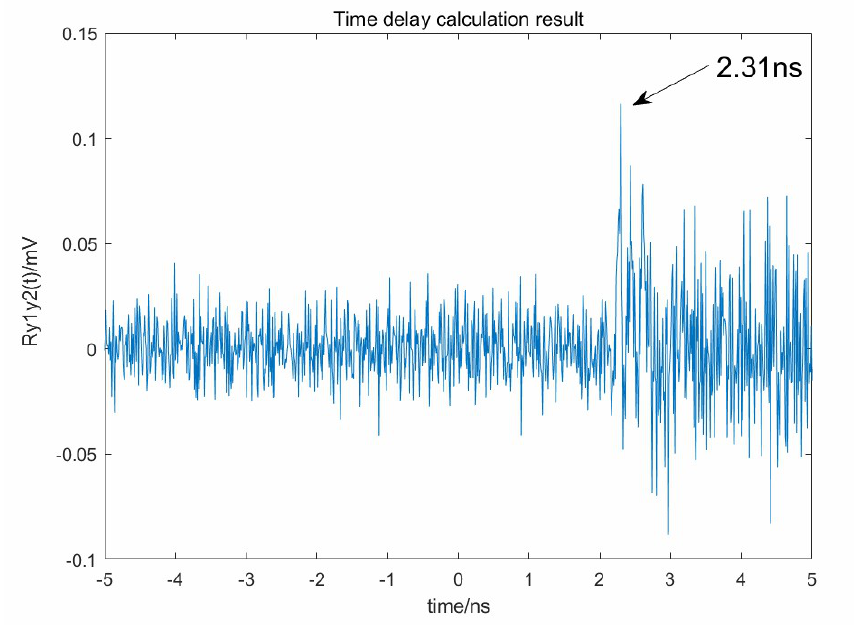
Figure 11. Time delay obtained the by HB weighting method.